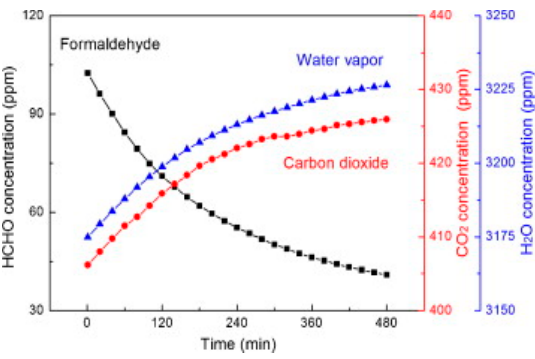
Figure 44. Degradation time vs. concentration of HCHO, CO 2 and H 2 O. Reproduced with permission from